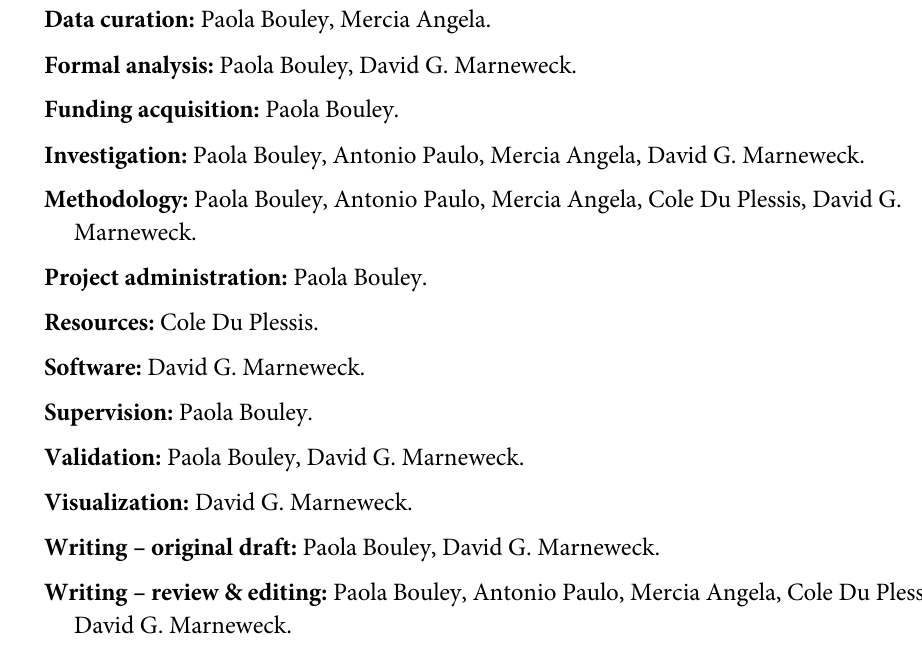
categories (woodland–grey; floodplain–green) are also shown. The total areas represent the merged 95% kernel UD isopleths from each pack per half of the study period. (TIF) S4 Fig. Area expansion for wild dogs. The monthly area size used by the reintroduced wild dogs between June 2018 and September 2020. Area size was delineated by the 95% minimum convex polygon enclosing all GPS fixes for all wild dogs